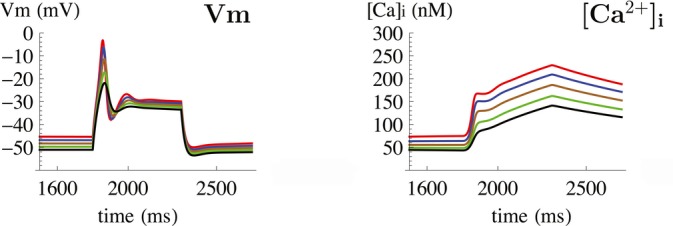
A free-running simulation of the effect on the myometrial action potential waveform of increasing densities of Kir7.1Time-dependent effect of increasing Kir7.1 channel densities on Vm (mV, left) and [Ca]i (nM, right). Increasing density of Kir7.1 within experimentally determined values hyperpolarizes resting membrane potential, whereas decreasing membrane excitability during depolarizing excursions in Vm leading to decreased calcium entry.